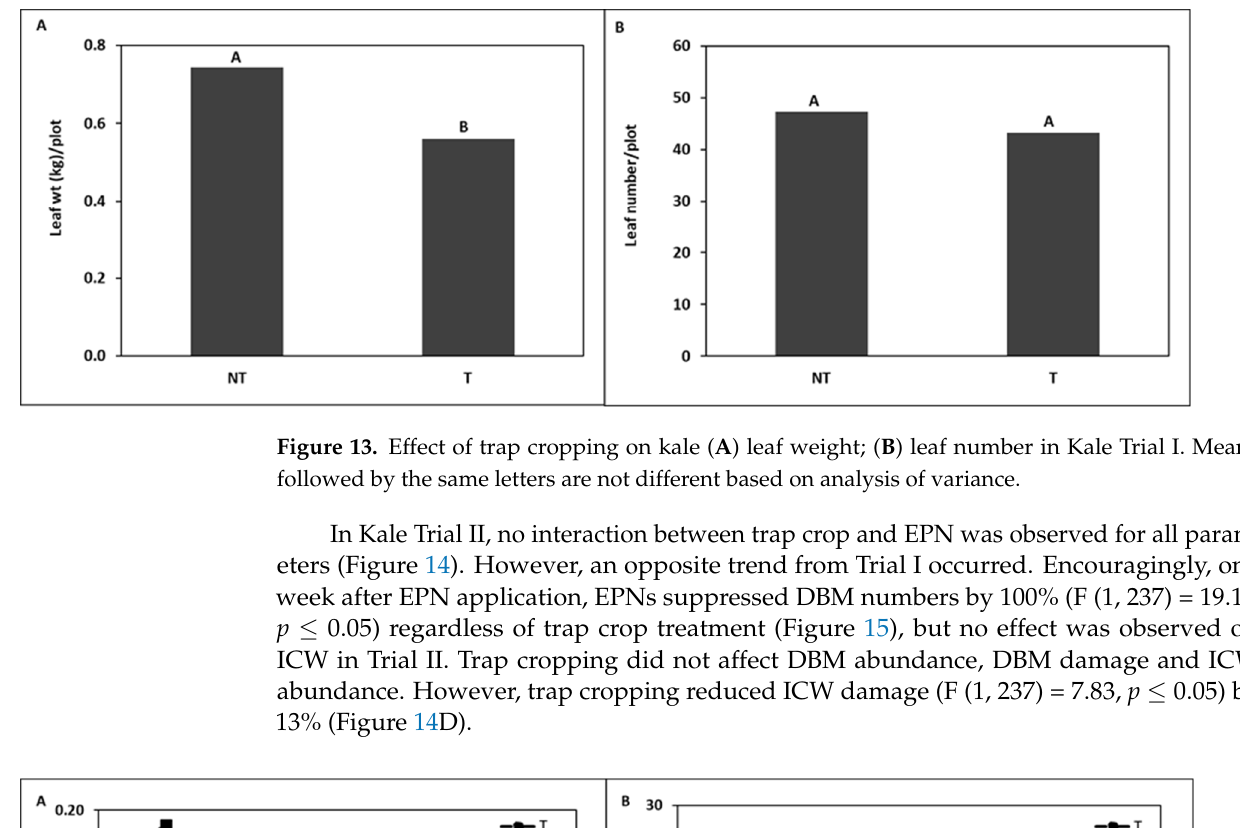
Figure 15. Effects of EPN on abundance of diamondback moth (DBM) in Kale Trial II. Means fol- lowed by the same letters in a graph are not different based on analysis of variance. When comparing kale and kai choi within the trap crop plots, ICW population (F (1, 300) = 37.42, p ≤ 0.01) and damage F (1, 300) = 17.10, p ≤ 0.01) were both higher on kai choi than kale (Figure 16A,C). Similarly, DBM numbers F (1, 300) = 20.55, p ≤ 0.01) and DBM damage (F (1, 300) = 11.23, p ≤ 0.01) were also higher on kai choi compared to kale (Figure 16B,D). No interaction between crop type and date was observed, thus only means of the crop type were presented.